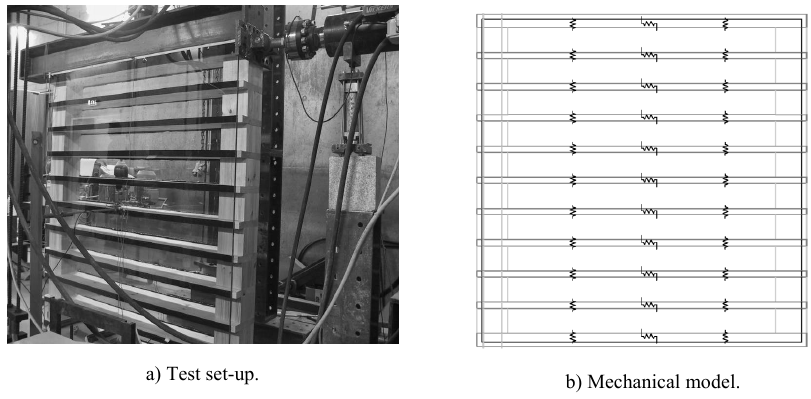
Figure 4: Timber-glass composite structural